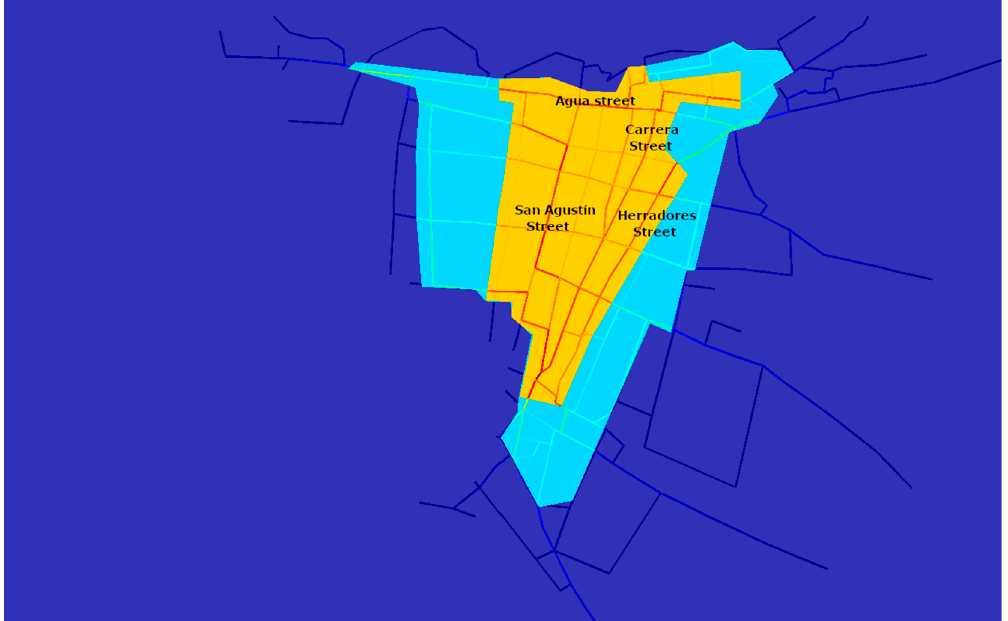
Figure 10. Importance of each street in the city using BC and population strata zones. The most important streets are in red tones, followed by the streets in cyan tones, and concluding with the streets in purple tones.